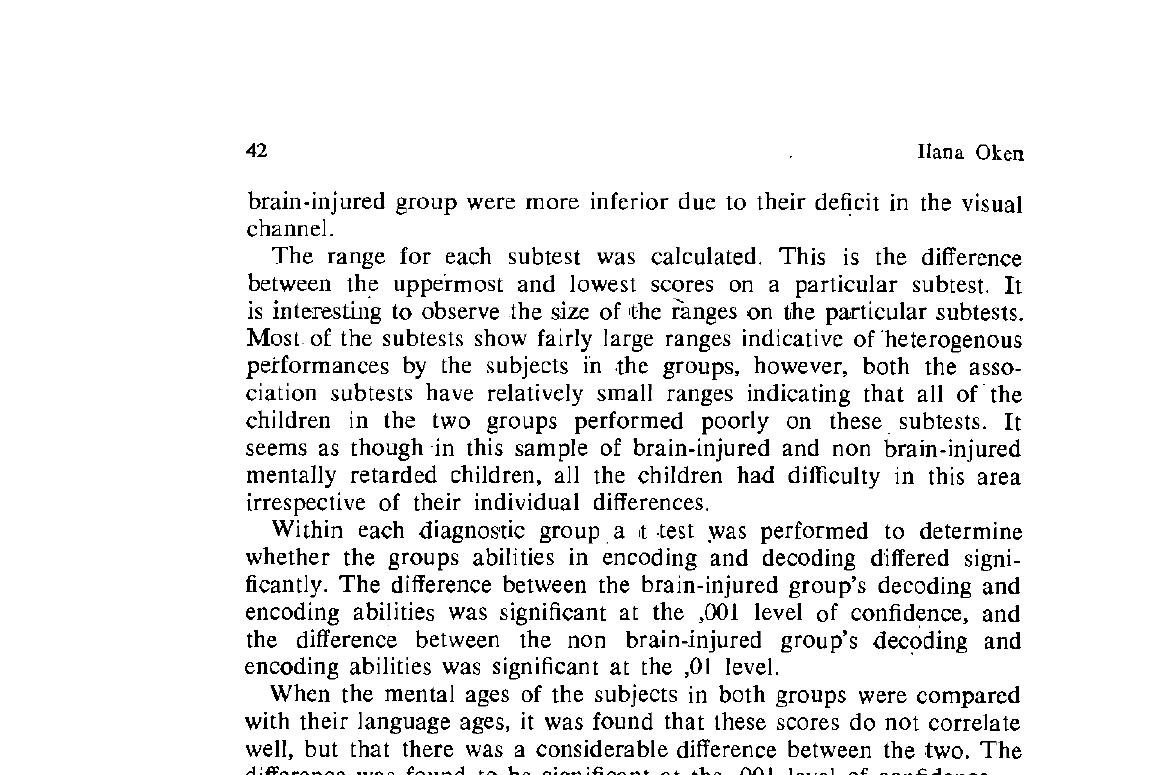
TABLE 3: RESULTS ON GENERALIZATION TEST OF THE BRAIN-INJURED AND NON BRAIN-INJURED